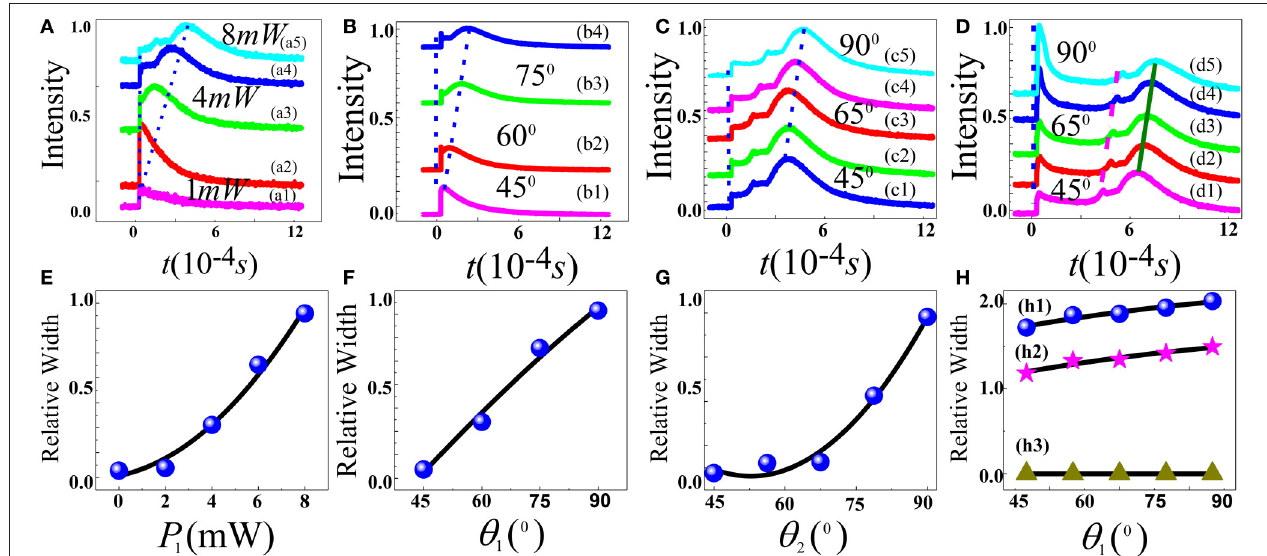
FIGURE 2 | (Color on-line) (A–D) show intensity of the composite FL signals in two-level system at 1 1 = 0 in time domain. Curves (a1–5) obtained by increasing power of E a from 1mW (bottom) to 2–4 mW, and then to 8mW (top), respectively. Curves (b1–4) obtained by changing and scanning E a polarization from 45 ◦ to 60 ◦ to 75 ◦ , and then to 90 ◦ by QWP, respectively, in two-level system. Curves (c1–5) obtained by changing E a polarization from 45 to 55 ◦ to 65 to 75 ◦ , and then to 90 ◦ by HWP, respectively, and scanning E b . Curves (d1–5) have similar conditions as curves (c1–5) but by QWP. Here, first, second, and third peaks are guided by short dashes, short dash-dot, and solid line, respectively. (E–G) Share same scale and show relative AT-splitting distance corresponding to (A–C) . (H) Shows distance between three peaks in (D) with respect to (w.r.t) polarization. The curve with circles (h1) shows distance between first peak and third peak of (D) w.r.t polarization. The curve with asterisk (h2) shows distance between first peak and second peak of (D) w.r.t polarization, and finally curve with triangles (h3) shows distance between second peak and third peak of (D) w.r.t polarization.